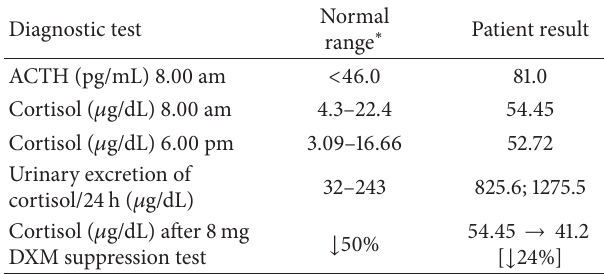
Table 1: Laboratory tests in patient at the moment of diagnosing Cushing’s